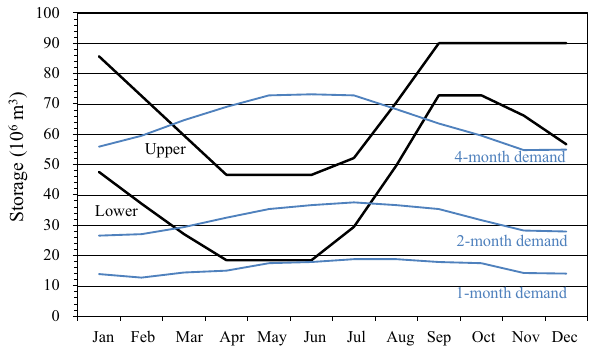
Fig. 2 Rule curves used in the current operation and the thresholds for various optimal hedging scenarios of the Nanhua Reservoir